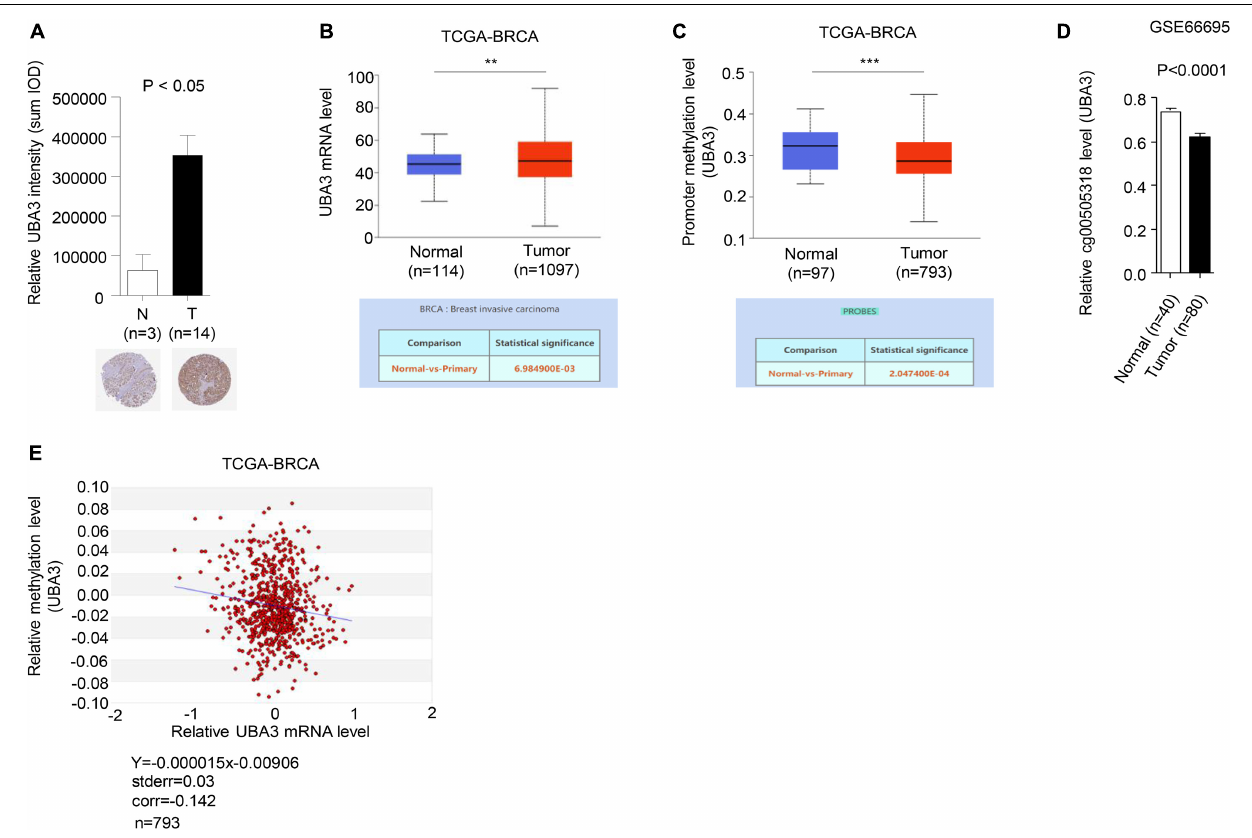
FIGURE 7 | UBA3 is upregulated and negative correlated with its promoter methylation level in breast cancer. (A) Representative images from immunohistochemical staining of UBA3 in breast tumors and matched adjacent tissues. The relative UBA3 expressions are shown as histogram. P -values were calculated by Student’s t -test. * P < 0.05. Data are shown as the mean ± SD. (B) The mRNA levels of UBA3 between normal and tumor tissues in the TCGA cohort of BRCA samples. * P < 0.05, ** P < 0.01, *** P < 0.001. (C) The methylation levels of UBA3 between normal and tumor tissues in the TCGA cohort of BRCA samples. * P < 0.05, ** P < 0.01, *** P < 0.001. (D) The relative promoter methylation levels of UBA3 between normal and breast cancer tissues in the GEO database (GSE66695). (E) The correlation between methylation percentage and mRNA levels of UBA3 in the TCGA cohort of BRCA samples. The blue line shows the linear regression of methylation percentage and mRNA expression